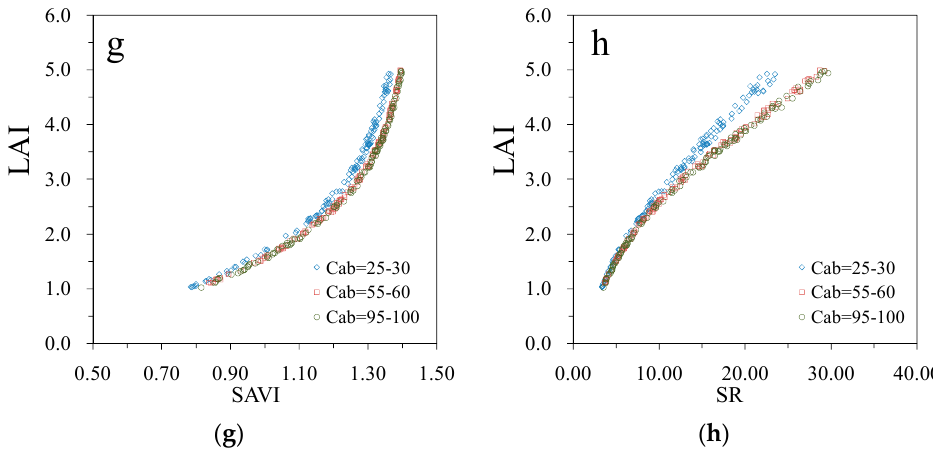
Figure 8. Correlation between vegetation indices and the leaf area index (LAI) for a fixed MTA of 57° and different leaf chlorophyll contents (Cab = 25–30, 55–60, 95–100 µg cm − 2 ): ( a ) BNDVI, ( b ) GARI, ( c ) GNDVI, ( d ) MSAVI, ( e ) MSR 705 , ( f ) NDVI, ( g ) SAVI, ( h ) SR. Canopy reflectance simulated with PROSAIL.